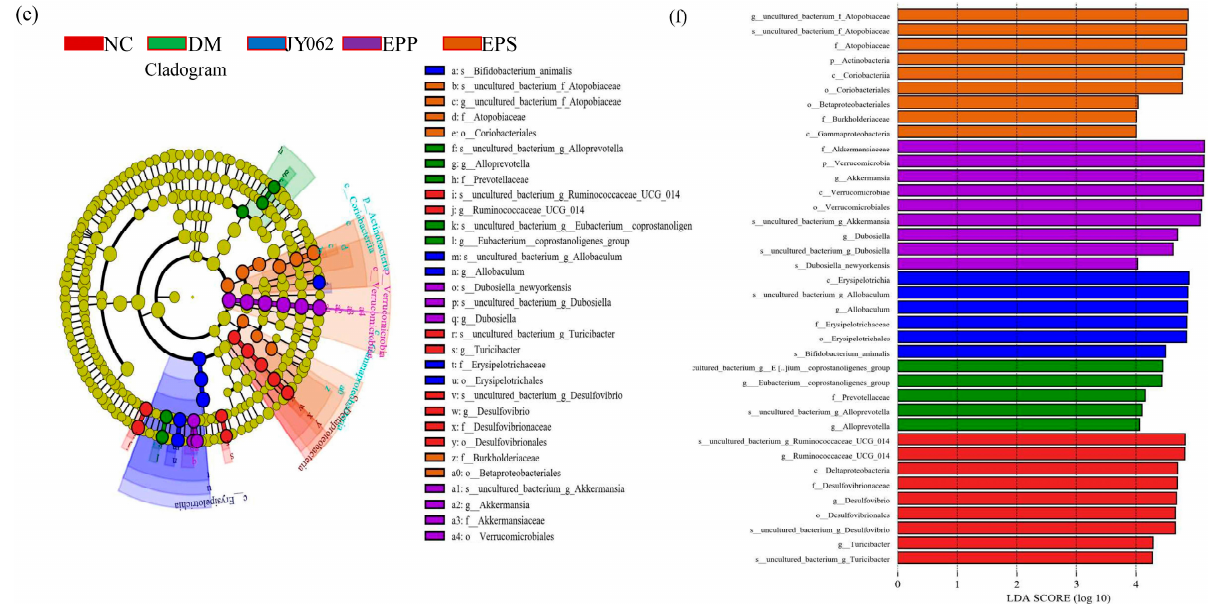
Figure 5. Differences in intestinal microbiota composition among the five groups ( n = 4). ( a ) Differences in the abundance of intestinal microbiota at the phylum level; ( b ) differences in the abundance of intestinal microbiota at the genus level; ( c ) the relative abundance of intestinal microbiota at the species level is depicted; ( d ) the relative abundance of the intestinal microbiota with the greatest change in each group is depicted; ( e ) the LEfSe results of significant differential biomarkers among the 5 groups based on a cladogram; ( f ) the LEfSe results of significant differential biomarkers among the 5 groups based on LDA score (log10). Data are presented as mean ± SEM ( n = 4), # p < 0.05, ## p < 0.01 vs. NC group; * p < 0.05, ** p < 0.01 vs. DM group.